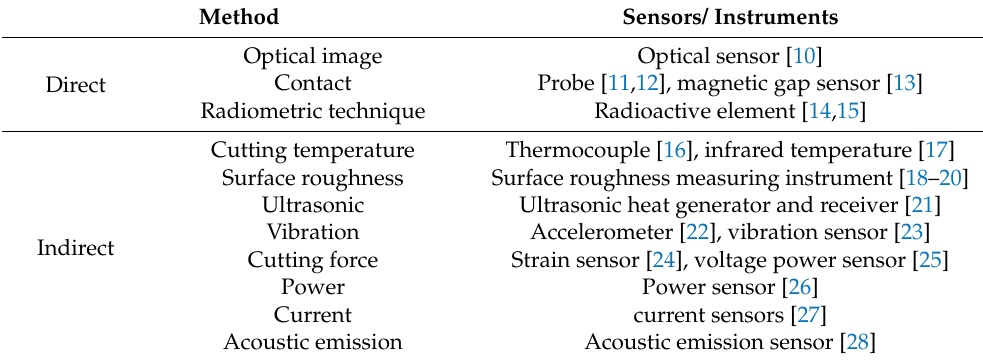
Table 1. Common TCM